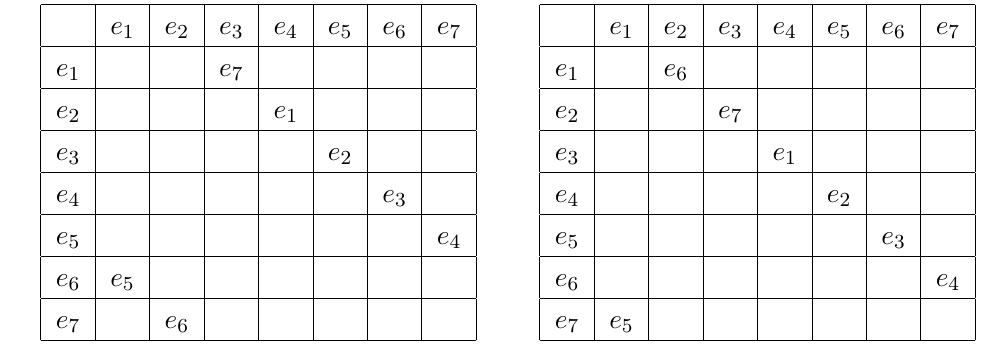
Table 1 . Table on the left is a C (+) table associated with the clockwise heptagon to be used later in section 4.1. It shows a part of the multiplication table in figure 2, where we keep only the information on associative triads, which makes the pattern of multiplication clear. For example, we see that e 1 e 3 = e 7 etc. . On the right there is a table for D (+) associated with the counterclockwise heptagon to be used later in section